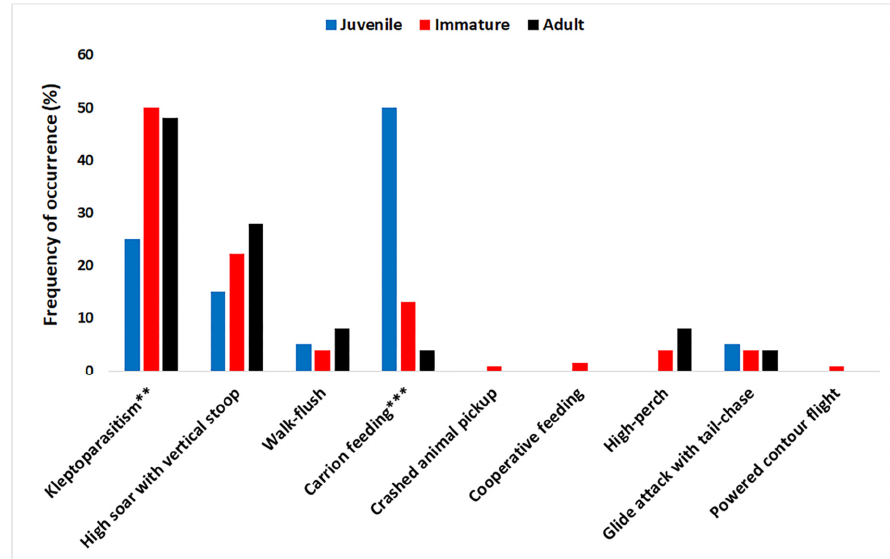
Figure 5. Frequency of occurrence (%) of different foraging modes used by different age classes of non-territorial Eastern Imperial Eagles. Significant values are given in *.